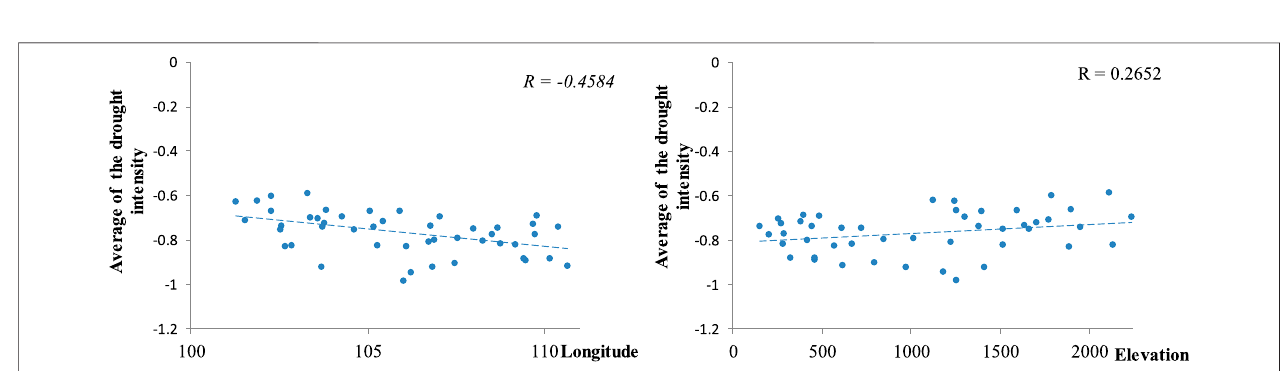
Frontiers in Environmental Science |